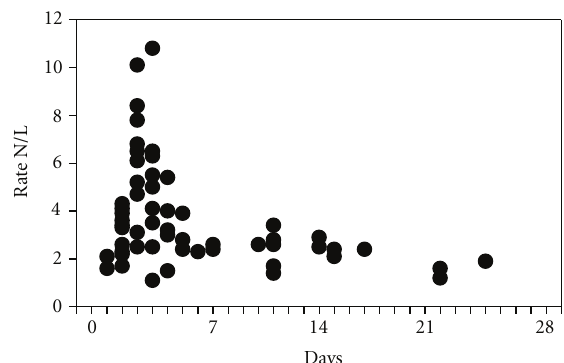
Figure 1: Individual values for the neutrophil/lymphocyte ratio (N/L) in patients with idiopathic sudden deafness ( n = 41). Each point corresponds to the day on which the patient sought emer- gency treatment. Day 0 indicates the appearance of sudden deafness. The dotted line shows normal values. (Spearman’s correlation coe ffi cient (Rho) = − 346; P = . 009).